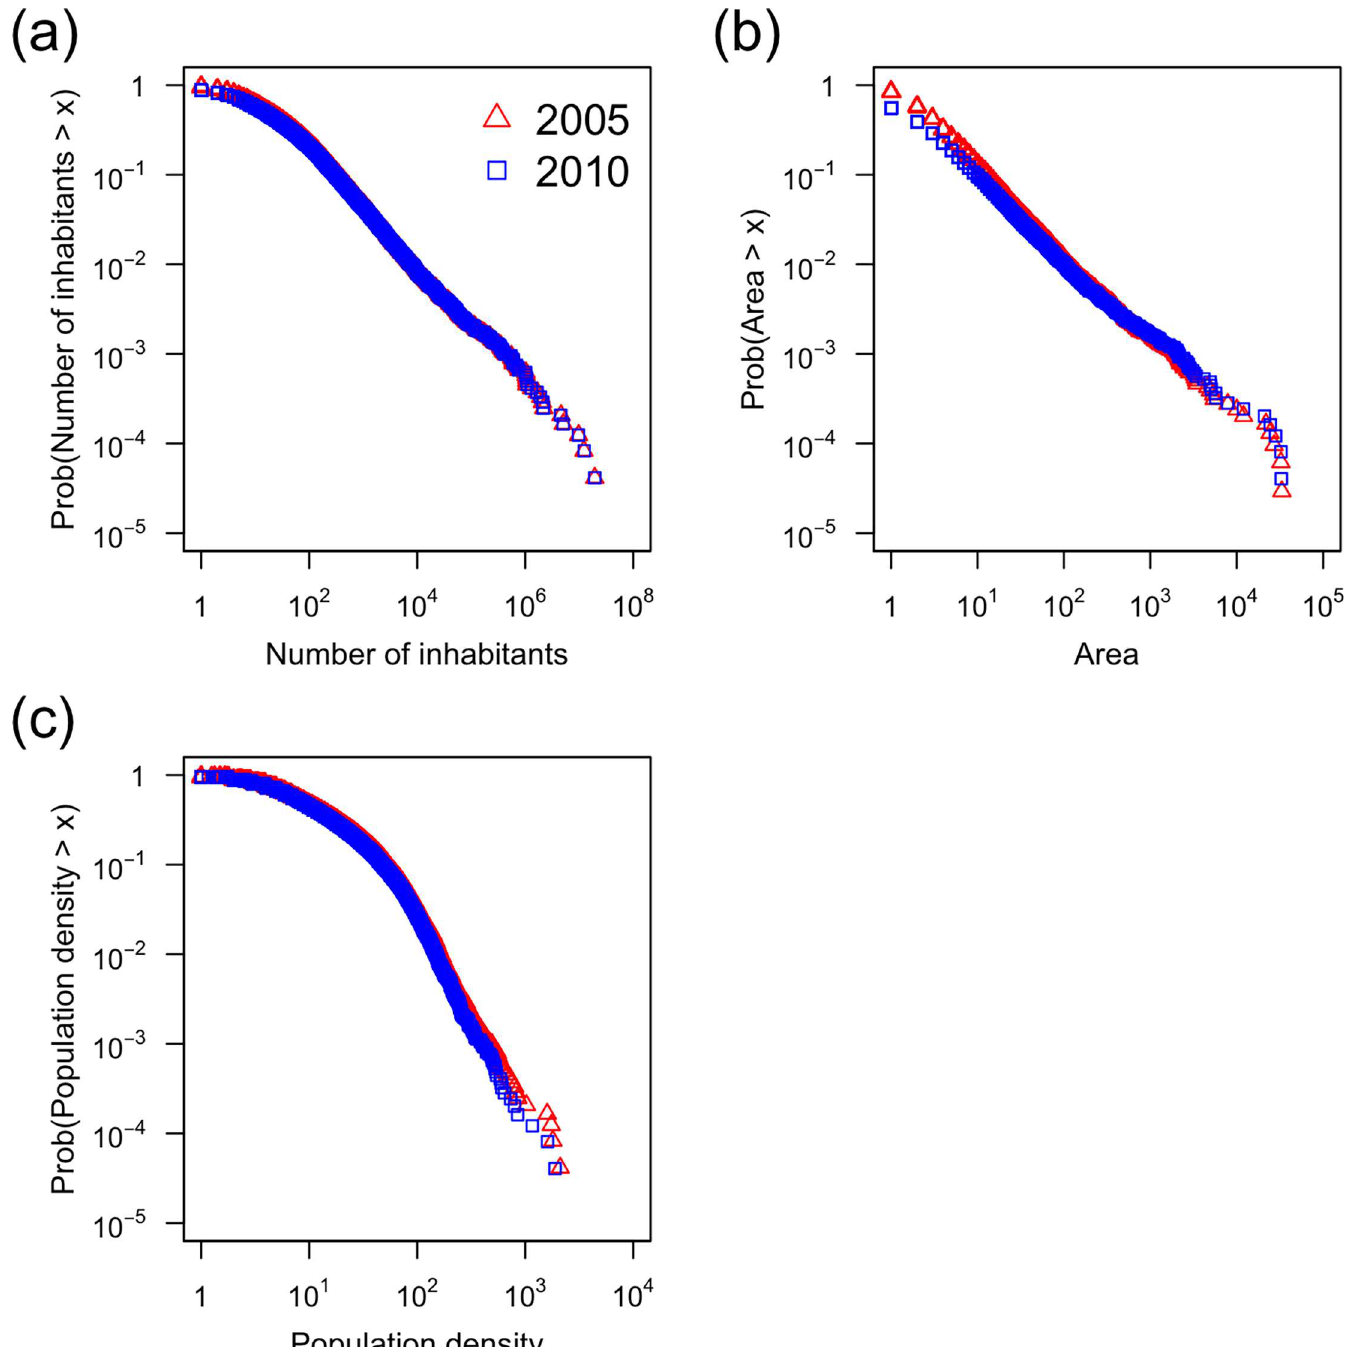
Fig 4. Complementary cumulative distributions for three properties of a cluster. (a) Number of inhabitants. (b) Area. (c) Population density. Differently from Fig 3, we used all the clusters to calculate the